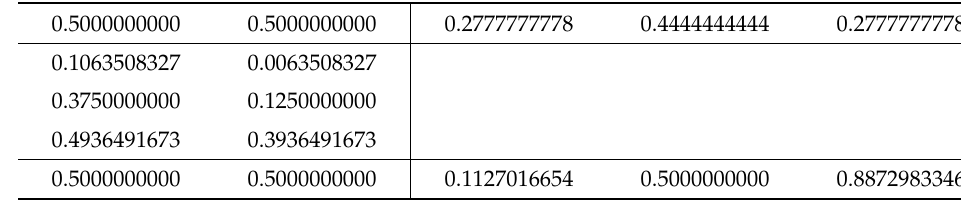
Table A28. eL2|G3 method.